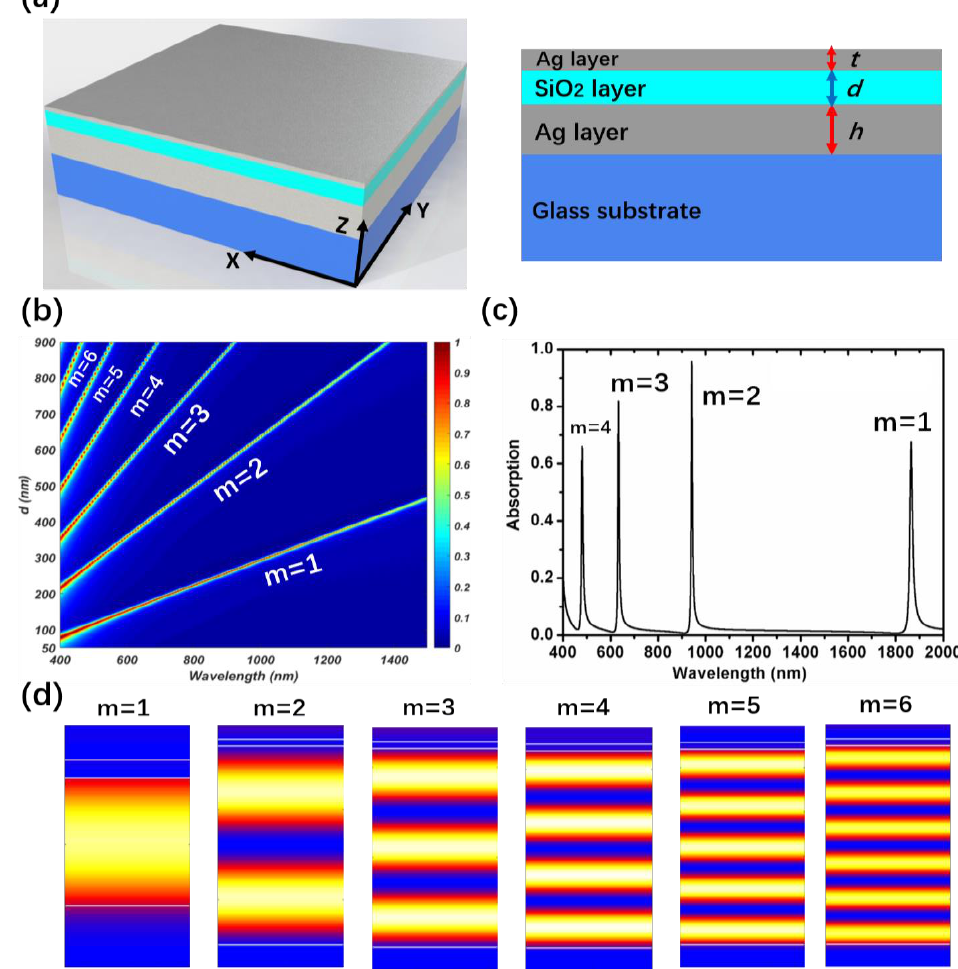
Figure 1. ( a ) Schematic diagram of the MDM structure perfect absorber. The thickness of the three layers are t , d , and h , respectively; ( b ) The relationship between the absorption and the SiO 2 thickness d by FDTD simulation when the thickness of the top Ag layer is 30 nm; ( c ) Simulated absorption spectra extracted from Figure 1b when d is 600 nm; ( d ) Electric field distribution in the SiO 2 cavity at the absorption peaks from m = 1 to m = 6.